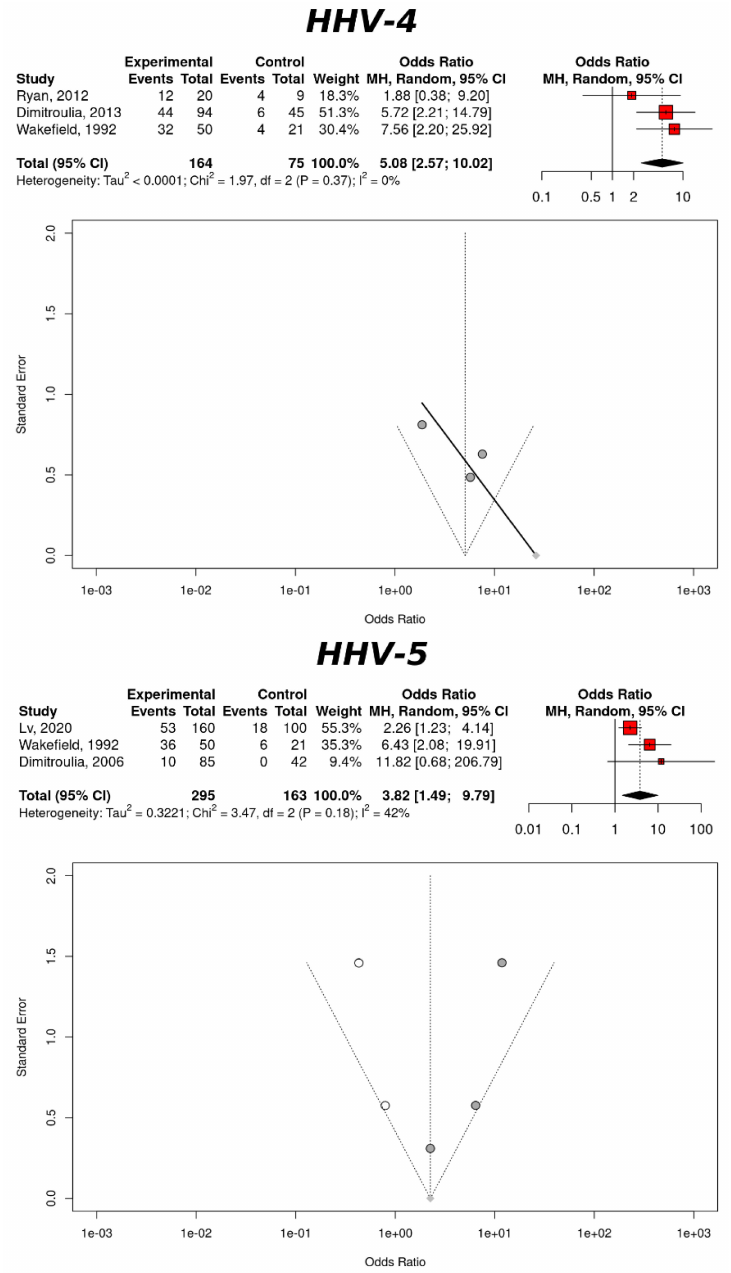
Figure 5. IBD risk and an infection with Herpesviruses based on the gastric tissues. The upper panel refers to HHV-4 (Epstein–Barr virus) and the lower panel refers to HHV-5 (Cytomegalovirus). Each panel includes a forest plot based on the random effects models and a funnel plot with a regression line. The studies added by the trim-and-fill method are represented by white